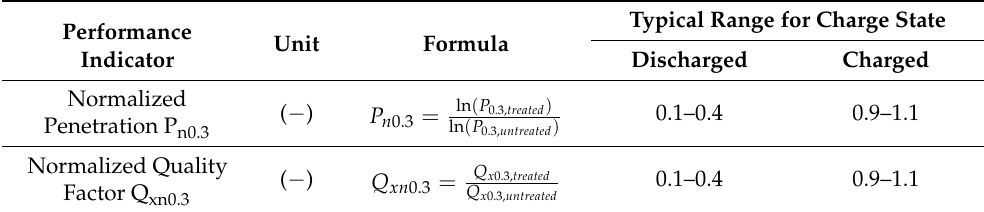
Table 3. Normalized filtration performance indicators—definitions and typical ranges. Performance